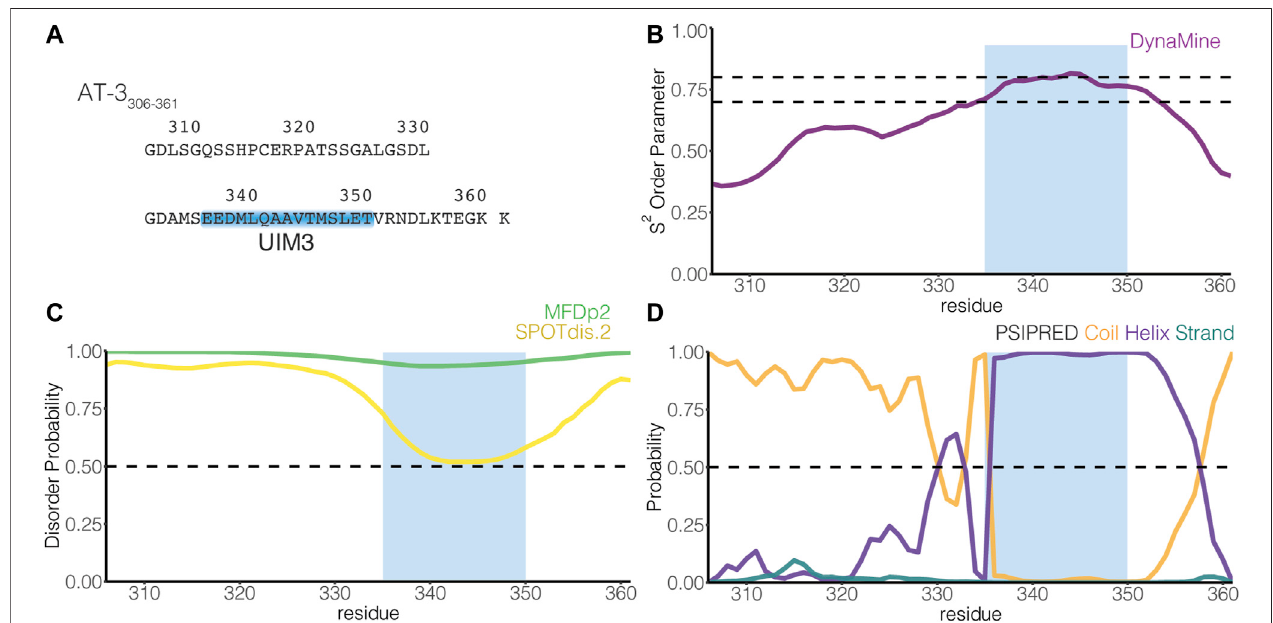
FIGURE 1 | The C-terminus of the UIM3 isoform of ataxin-3 is predicted disordered and includes a UIM. (A) The fi gure illustrates the amino acid sequence of AT- 3 306-361 . The blue box indicates UIM3 of AT-3 (residues E336-T350). (B) The panel shows the residue-wise prediction of the S 2 order parameter in AT-3 306-361 from DynaMine (purple). The dashed lines show the thresholdsof S 2 predicted scores toclassify residues as ordered (S 2 ≥ 0.75), context-dependent(0.65 < S 2 < 0.75), and disordered (S 2 ≤ 0.65). (C) The panel shows the residue-wise prediction of disorder propensity in AT-3 306-361 from the Multilayered Fusion-based Disorder predictor v. 2.00 (MFDp2, green), and SPOT-Disorder2 (SPOTdis.2, yellow) predictors. The dashed line shows the threshold of disorder probability to classify the residues as disordered ( ≥ 0.5) and ordered ( < 0.5). (D) The plot shows the residue-wise prediction of secondary structure propensity (Coil orange, Helix violet, Strand teal) from PSI-PRED . The dashed line shows the threshold of secondary structure probability for each structural class to classify the residues as coil, helix or strand ( ≥ 0.5).ThelightblueboxindicatesUIM3.ThepredictorsreportAT-3 306-361